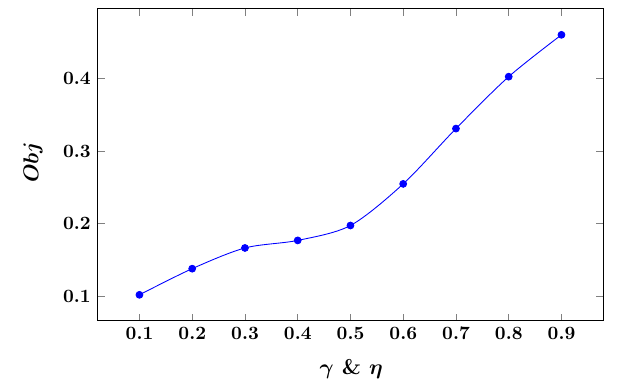
Fig. 2 The optimal value of the objective function for different values 𝛾 and 𝜂